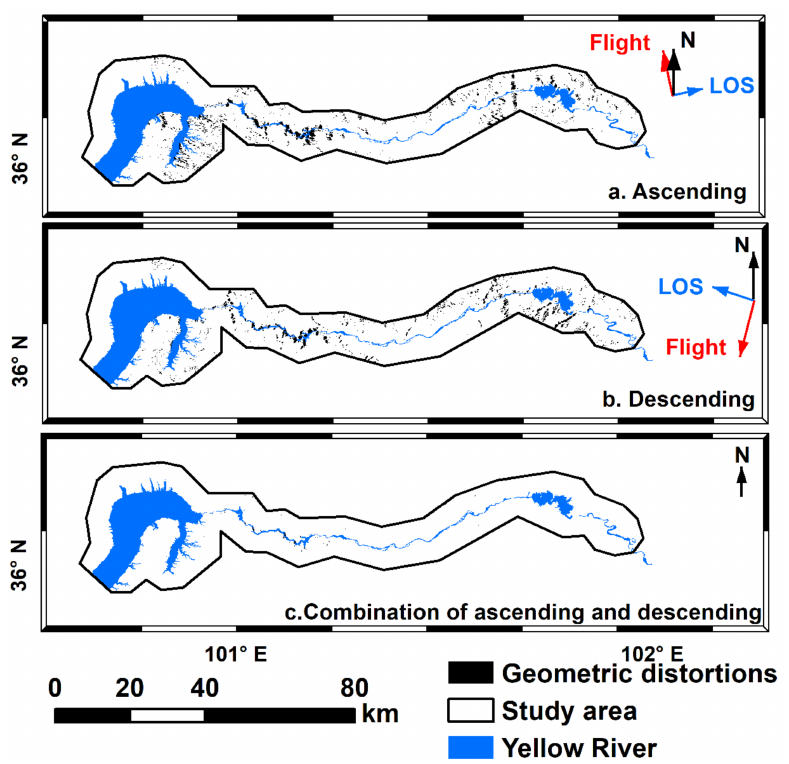
Figure 4. Radar geometric distortion regions of Sentinel-1 satellite from ascending and descending orbits. ( a ) Synthetic aperture radar (SAR) geometric distortions of Sentinel-1 ascending images; ( b ) SAR geometric distortions of Sentinel-1 descending images; and ( c ) SAR geometric distortion following the combination of Sentinel-1 ascending and descending images.